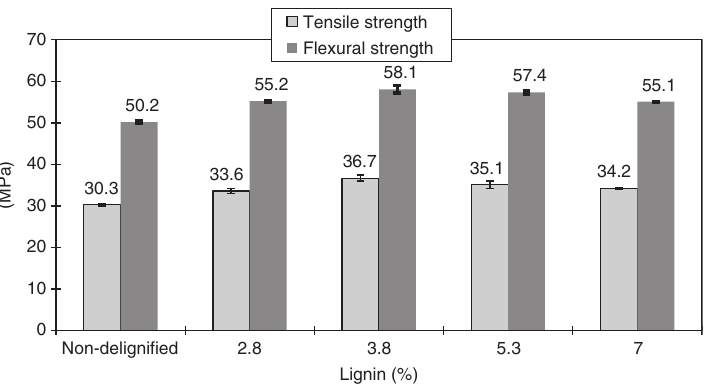
Figure 1: Influence of OCC fiber characteristics on the tensile and flexural strengths of OCC fiber/polypropylene